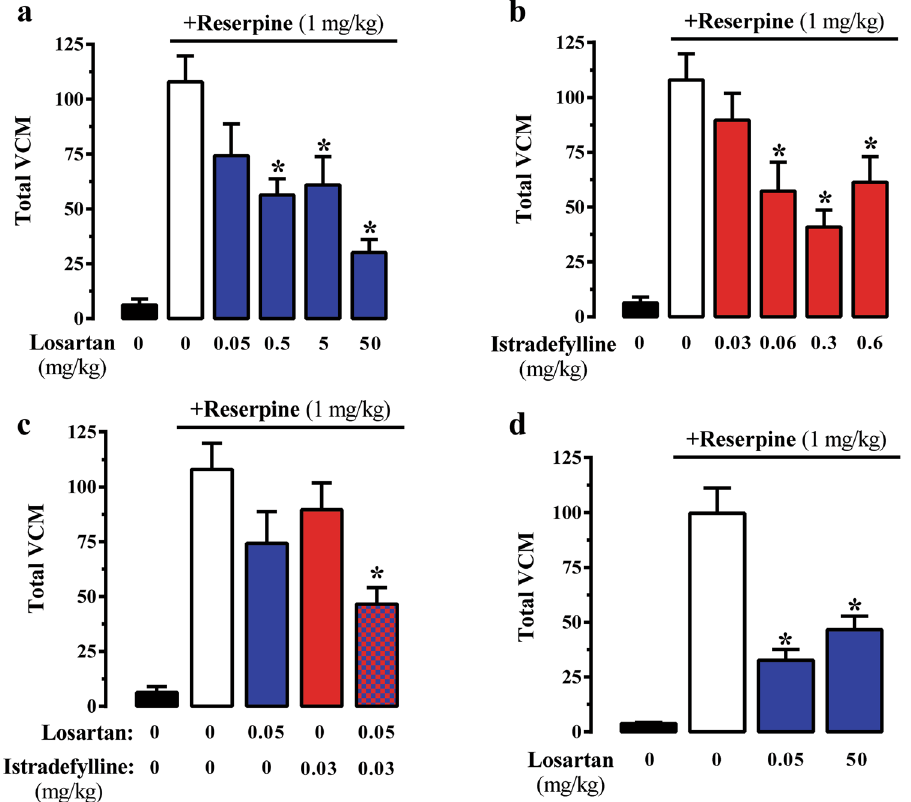
Figure 5. Effect of AT 1 R and A 2A R blocking in the TD animal model. The effect of different doses of losartan ( a ) or istradefylline ( b ) on total vacuous chewing movements (VCM) in the reserpine-based animal model of TD in mice was monitored during 10 min. (c) Effects of sub-effective dose co-administration (i.p.) of losartan (0.05 mg/ml) and istradefylline (0.03 mg/ml) in the VCM of TD animal model. ( d ) Effect of losartan in the VCM of TD animal model performed in A 2A R-KO mice. Results are represented as the mean ± SEM (n = 10 animals). * P < 0.05 compared to the vehicle group (one-way ANOVA, followed by Newman-Keuls